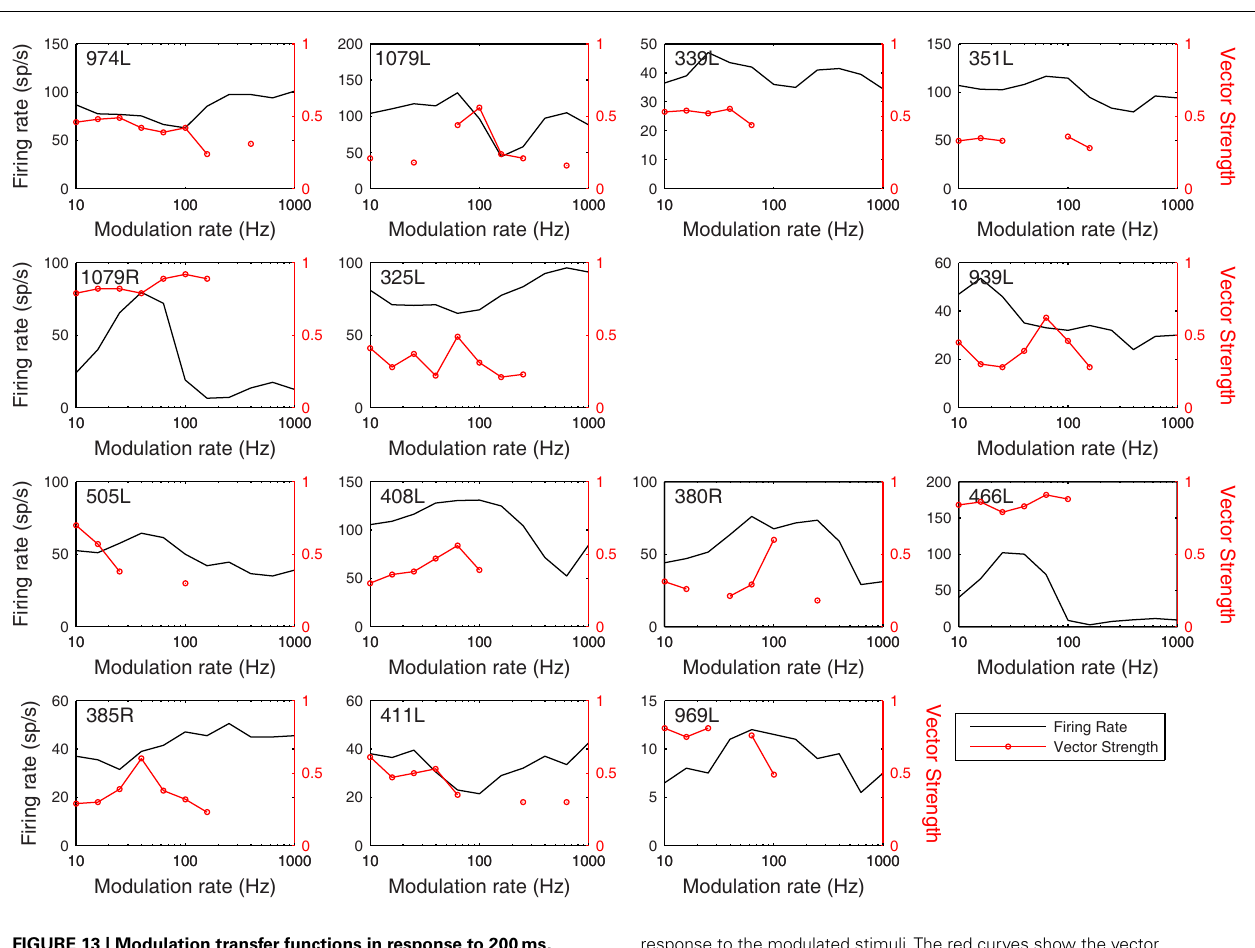
FIGURE 13 | Modulation transfer functions in response to 200ms, 100% amplitude modulated CF tones arranged in the same order as previous figures. The black lines show the average discharge rate in